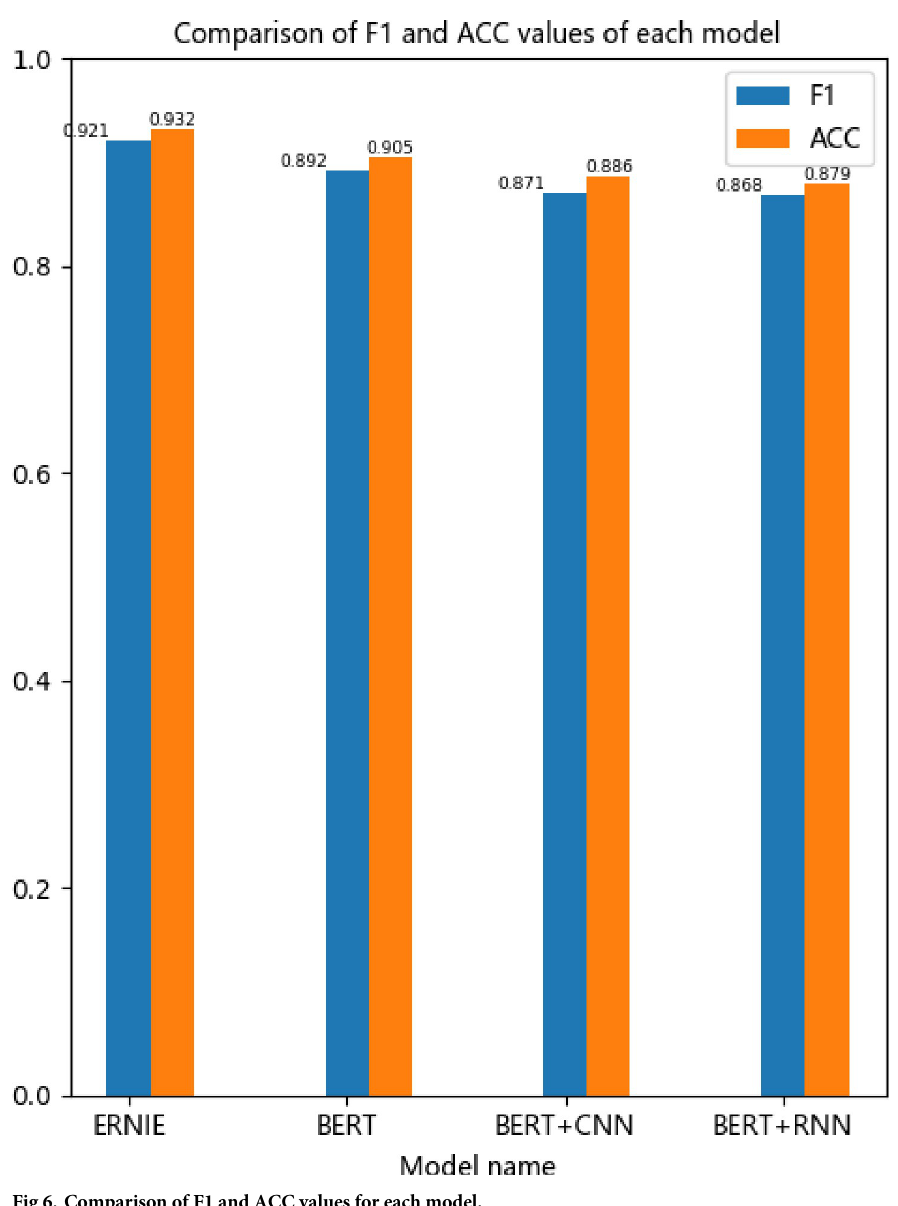
Fig 6. Comparison of F1 and ACC values for each